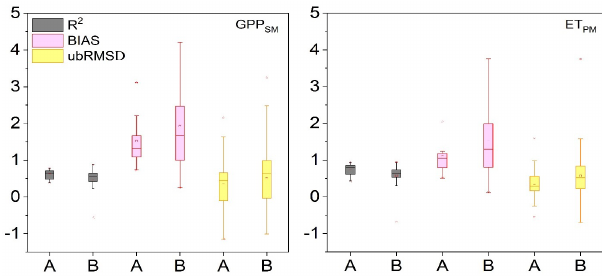
Figure 9. Box plots of R 2 , ubRMSD, and BIAS for GPP SM (a) and ET PM (b) . A represents the sites in arid and semi-arid areas, and B represents the sites in humid and dry sub-humid